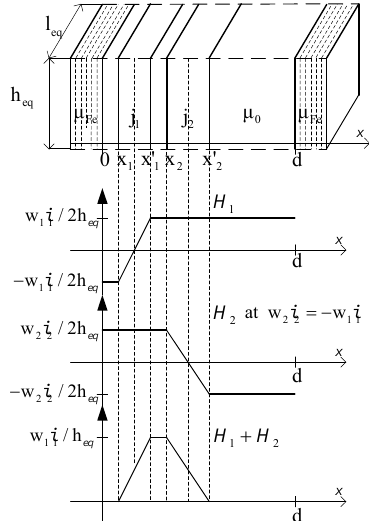
Figure 8. Magnetic field distributions in the air zone for 1D approach.